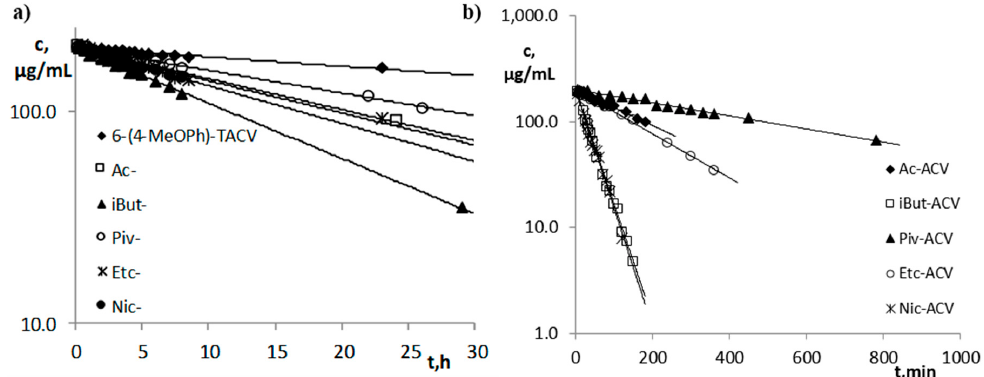
Figure 2. Semi-logarithmic plots of the c t = f ( t ) response of the hydrolysis reaction in plasma (80%, 37 ◦ C): ( a ) 6-(4-MeOPh)-TACV and its esters; ( b ) acyclovir esters. Studies on the susceptibility of compounds to hydrolysis in plasma have shown that the tricyclic derivatives of ACV (6(4-MeOPh)-TACV and its esters) are characterized by high stability under the above conditions (Figure 2a). The fastest decomposition occurred for the i But ester, for which t 0.5 was 11.52 h (Table 2). The parallelism test showed that the difference in the stability of the Ac- and Etc- esters in the plasma is statistically insignificant. Susceptibility to hydrolysis in the plasma of tricyclic compounds can, therefore, be ranked as follows: